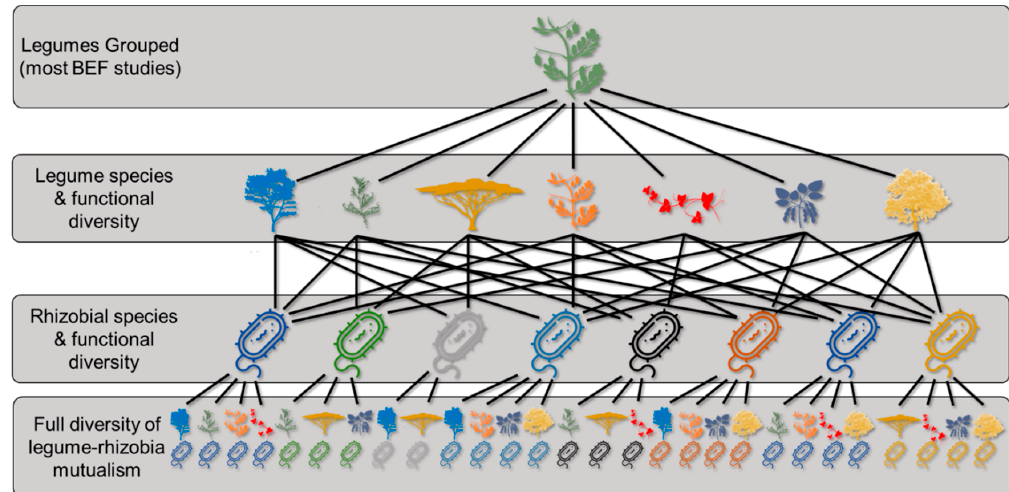
Figure 2. Unseen diversity in the legume–rhizobia mutualism. Studies on BEF relationships have traditionally viewed N fixers as a single functional group, simply focusing on the presence or absence of N fixers in a community (top tier). However, in many ecosystems, substantial species and functional diversity exists within the legumes (second tier) and their rhizobial partners (third tier; Figure 1). Because both legumes and rhizobia can be promiscuous in terms of the species with which they partner, the number of combinations of legume–rhizobia mutualisms that can exist in an ecosystem far exceeds the diversity of either partner group on its own (bottom tier). In nature, the effect of promiscuity on legume–rhizobia diversity is likely even greater than depicted here, given that individual legume plants can often partner with multiple rhizobial species at the same time. Accounting for this substantial diversity within the legume–rhizobia mutualism may be critical to fully understanding how N fixers influence BEF